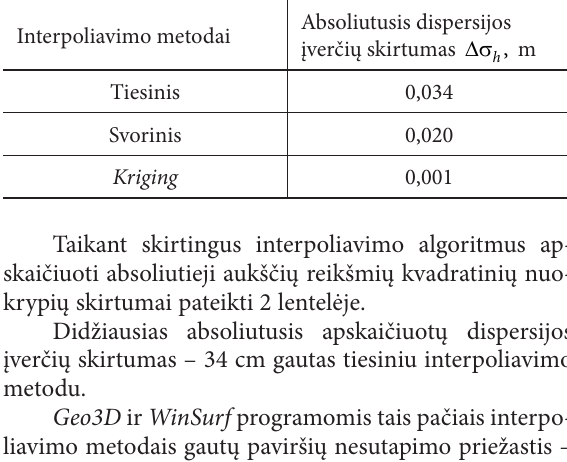
Table 2. Absoliute ddiscrepancies between the estimated dis- persion of height data interpolated by Geo3D and WinSurf pro- grams Interpoliavimo